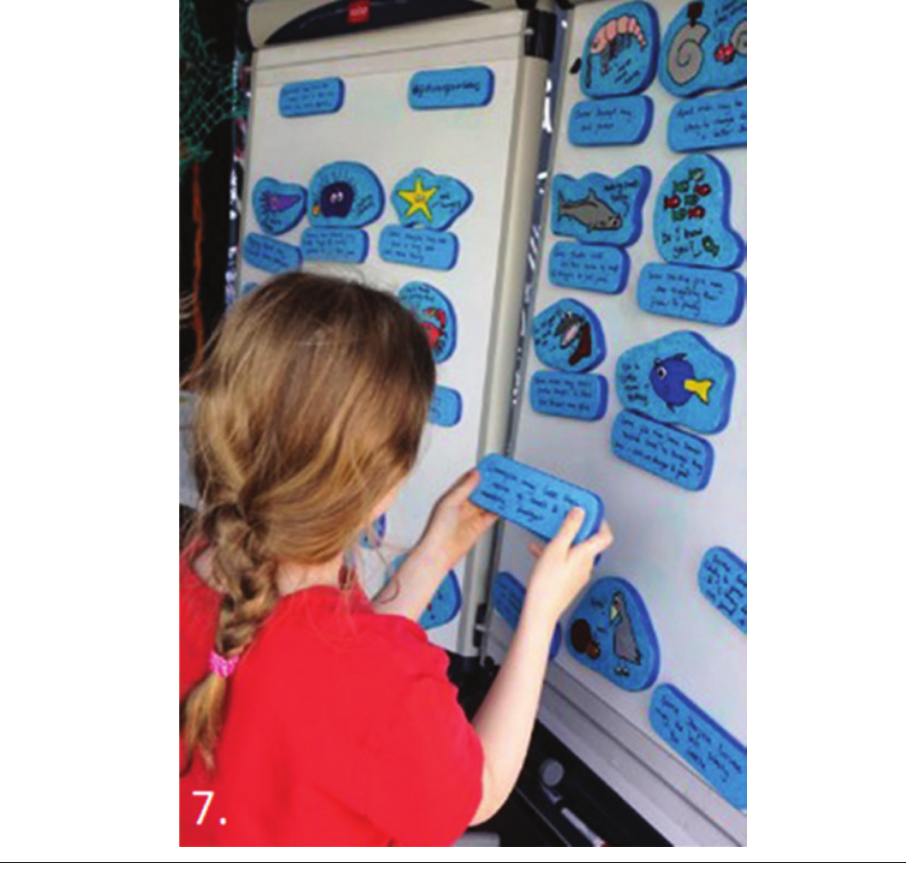
figure 9: Understanding ocean acidification through a cartoon magnet game (photograph: aquarela Images)